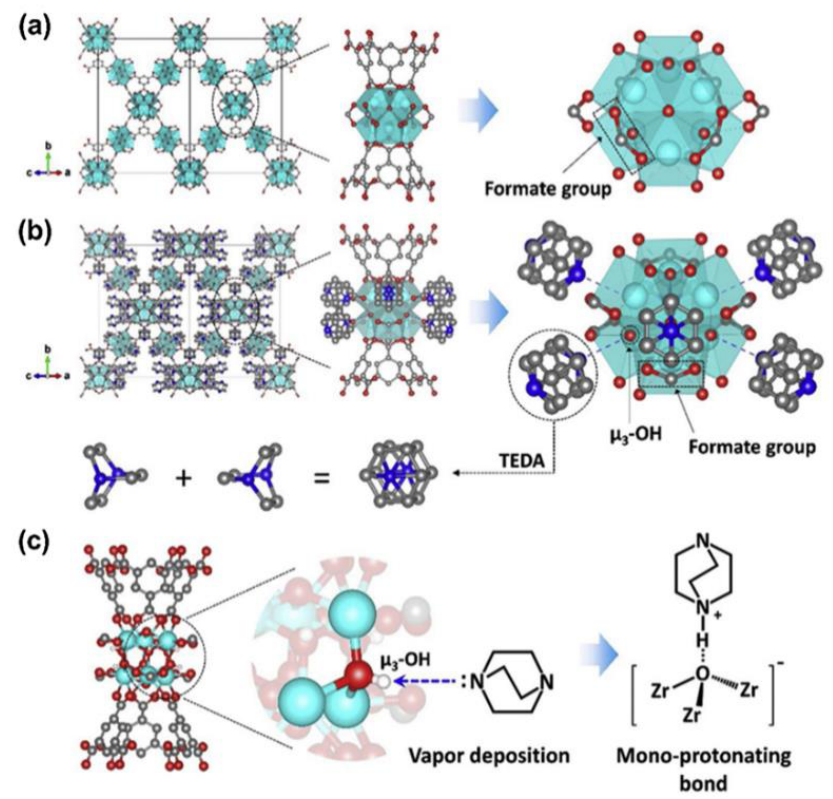
Figure 6. Synthetic route and combination mode of MOF – 808 – TEDA. ( a ) MOF – 808; ( b ) T – MOF – 808. The polyhedrons represent ZrO 8 groups. Atom colors: Zr: cyan; C: dark gray; O: red; and N: blue. Water molecules were excluded. ( c ) Schematic representation of TEDA (triethylenediamine) functionalization of MOF – 808 [37a].